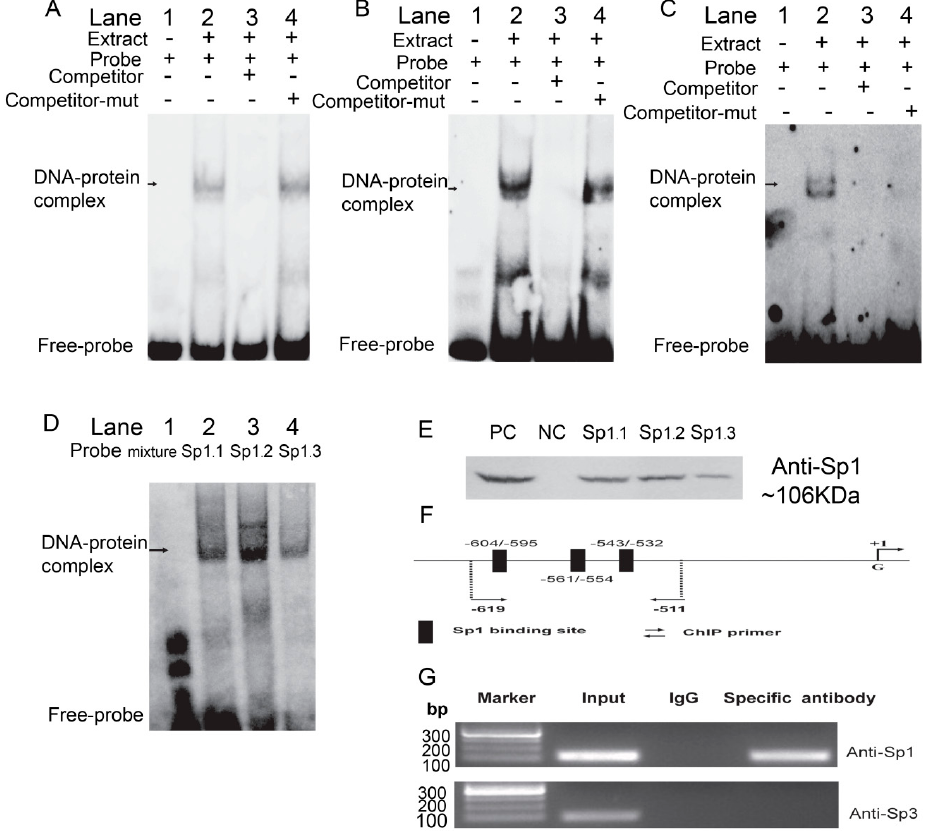
Figure 3. Binding of Sp1 with the ROCK1 -P5 fragment was analyzed in vitro and in vivo . The first ( A ), the second ( B ) and the third ( C ) biotin-labeled probes were incubated with the NE of PK cells. Lane 1 was the negative control without NE; the reagents were incubated in the absence competitor probes in Lane 2 or in presence of 50 ˆ excess competitor (Lane 3)/competitor-mutant (Lane 4) probes, respectively; ( D ) The three probes were incubated with PK NE, respectively; ( E ) Proteins of PK extracted from DNA-pull down materials were detected by Western blot. The total non-denaturing proteins/Streptavidin MagneSphere ® Paramagnetic Particles were taken as positive/negative control (PC/NC). The three potential Sp1 binding sites were named as Sp1.1, Sp1.2, and Sp1.3 in ( D , E ). The competitor/competitor-mutant probes were 50-fold excess and arrows indicated the specific DNA-protein complex bands; ( F ) Schematic diagram of the Sp1 binding sites in the porcine ROCK1 -P5 fragment; ( G ) ChIP assay of Sp1 binding to porcine ROCK1 -P5 fragment in PK cells. The in vivo interaction of Sp1 and Sp3 with porcine ROCK1 promoter was determined by ChIP assay, in which Normal mouse IgG was used as negative control. DNA isolated from immunoprecipitated materials was used for PCR amplification, whereas total chromatin was used as input (positive control). The antibodies used in ChIP assay were listed in the right of the figure and the corresponding amplification product obtained here was 107